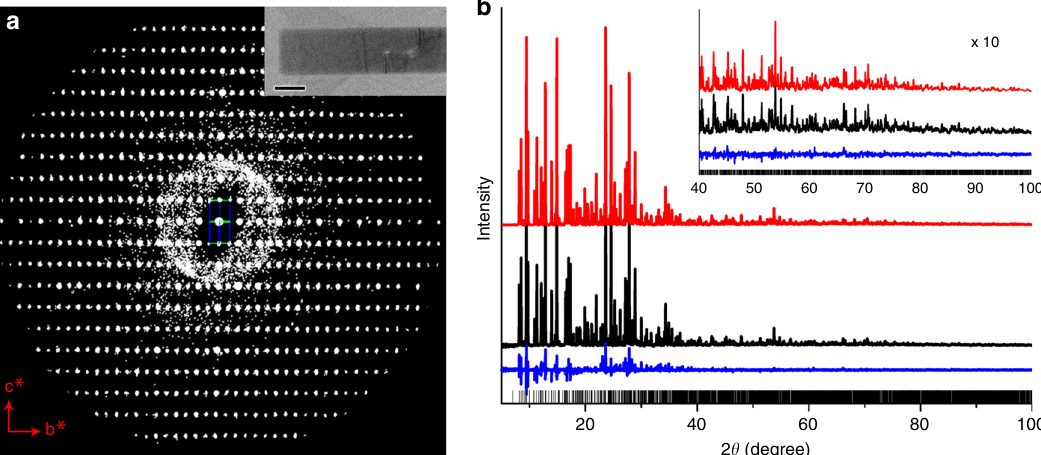
Fig. 1 Reconstructed 3D reciprocal lattice and Rietveld re fi nement. a Reconstructed three-dimensional reciprocal lattice of PST-5 from the continuous rotation electron diffraction ( c RED) data viewed along the [100] direction. Inset is the crystal of PST-5 from which the c RED data was collected, scale bar = 500 nm. b Powder X-ray diffraction (PXRD) pro fi les of Rietveld re fi nement for PST-5 ( λ = 1.5474Å): observed, calculated and difference pro fi les are shown in red, black, and blue, respectively. The bars represent the positions of allowed re fl ections.